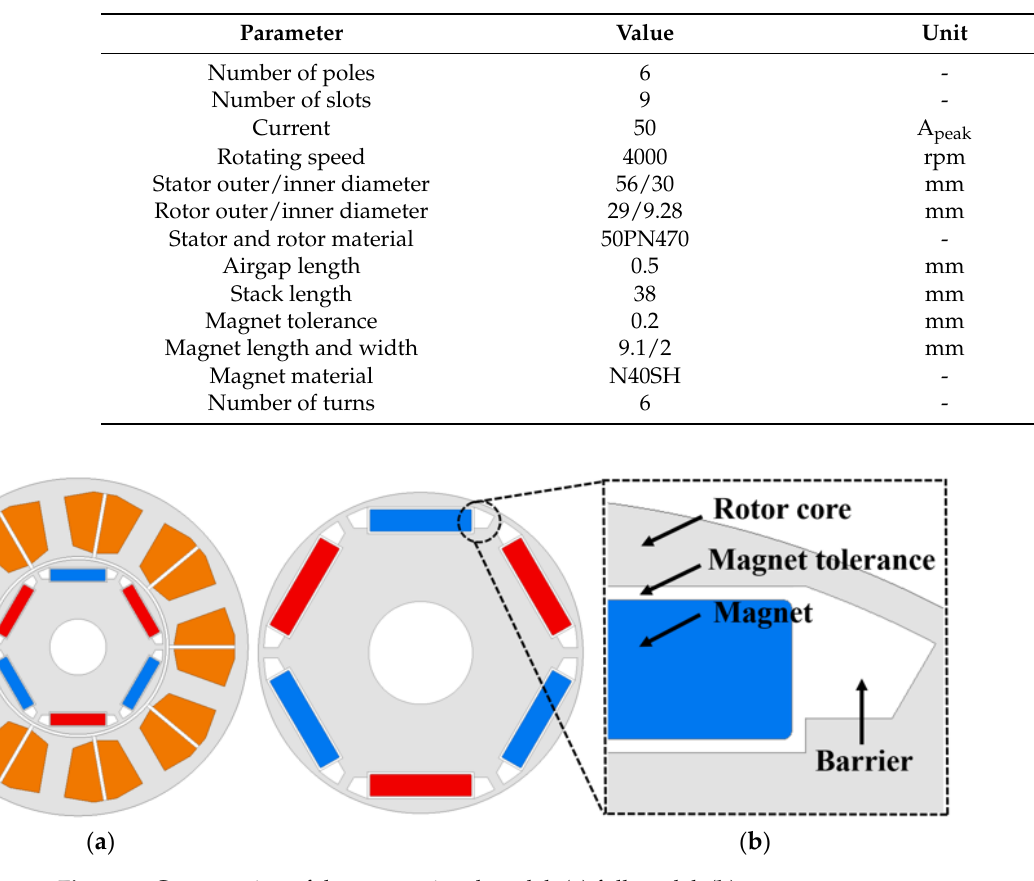
Figure 5. Cross-section of the conventional model: ( a ) full model; ( b ) rotor. Table 1. Specifications of the analysis model.